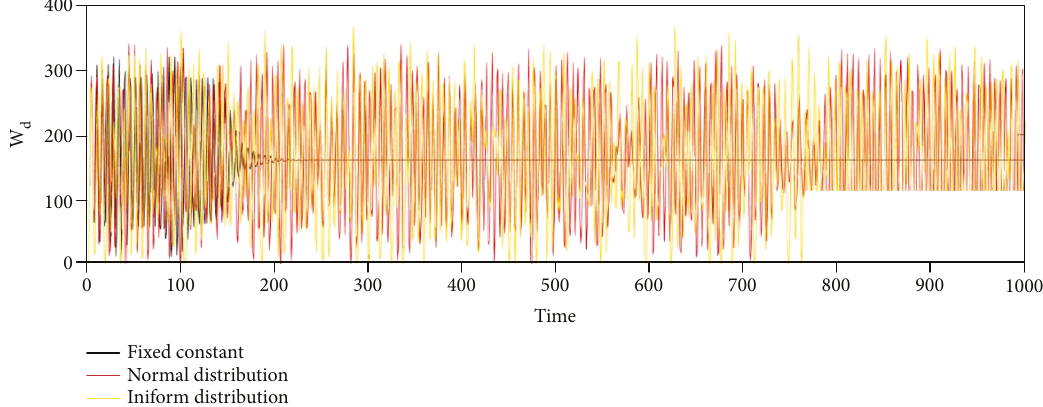
Figure 12: Change in tra ffi c volume of third-party logistics service providers in an unstable state under the three demand